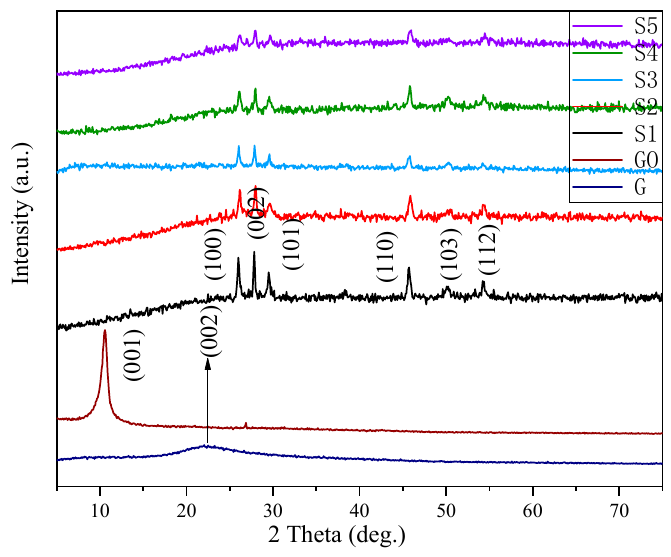
Figure 2. XRD patterns of graphene, GO, NCs, and γ MnS.